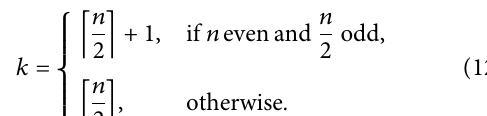
Figure 1: The illustration of labeling on S